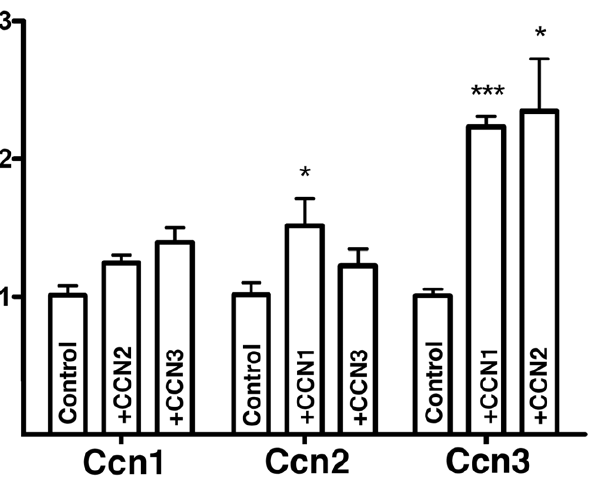
Figure 5. Chart showing the regulation of the Ccn1 , Ccn2 , and Ccn3 genes in the interdigital mesoderm 6 hr after the implantation of beads bearing PBS (control), CCN1, CCN2 or CCN3. (*) p-value # 0.05; (***) p-value # 0.001.